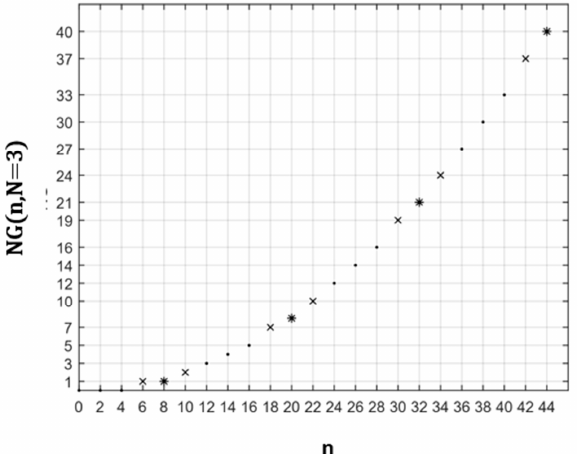
Figure 11. Dependence of the number of graphs NG (n, N = 3) as a function of even n. • : (n ∈ {2𝑘 ̸ 𝑘 ∈𝐼𝑁} , even q); x : ( n∈{6+4𝑘 ̸ 𝑘 ∈𝐼𝑁} , odd q); * : (n ∈(cid:3419)8+4𝑘 /̸𝑘 ∈𝐼𝑁(cid:3423), odd q). 6. Conclusions Over the last years, the use of drones is leading to new working models in a variety of logistic scenarios. This happens in both developed and developing countries. Currently,